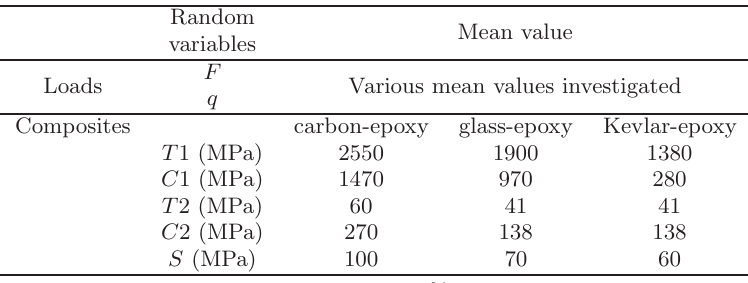
Fig. 5. Principal material coordinate system for unidirectional composite. Table 2. Random variables.